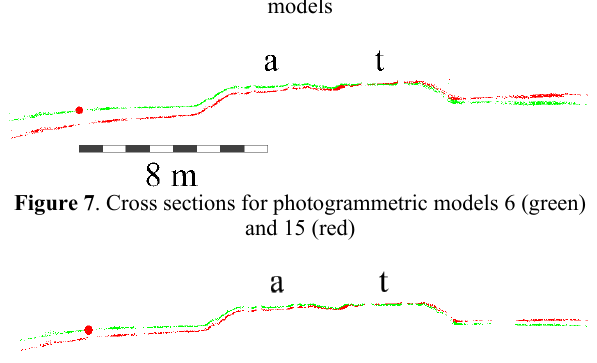
Table 4. Maximum errors of generated photogrammetric